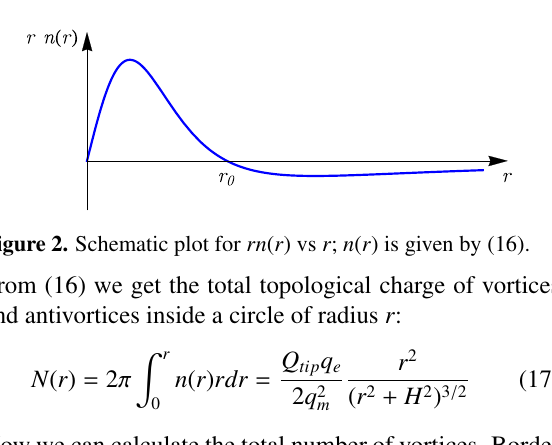
Fig.4 shows a typical low-temperature configuration of the system for higher values of the tip’s voltage. Vortices and antivortices are arranged in a highly regular structure that is reminiscent of the structure of an atom: